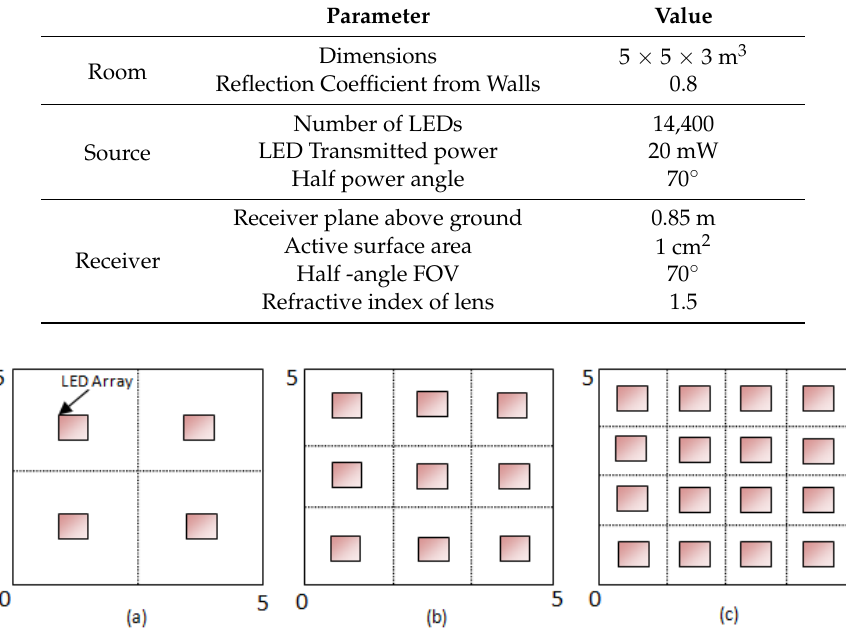
Figure 1. LEDs arrangements for ( a ) the 4 arrays model, ( b ) the 9 arrays model, and ( c ) the 16 arrays model. Table 1. Visible light communication (VLC) System Parameters.